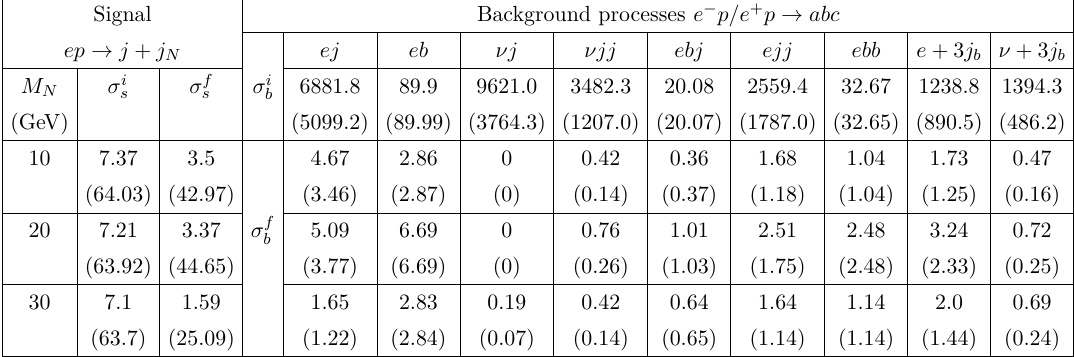
implies including light jet and b jet. The b